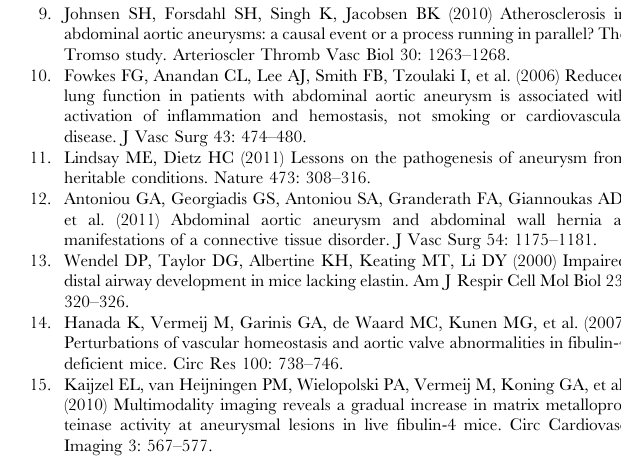
Table S1 Clinical characteristics of patients with de- scending thoracic aortic aneurysm (TAA) or abdominal aortic aneurysm (AAA). Table S2 COPD in patients with descending thoracic aortic aneurysm (TAA) or abdominal aortic aneurysm (AAA). Table S3 Association between COPD and aneurysmal disease. Table S4 The most significantly down-regulated genes in lungs of adult Fibulin-4 R/R mice. Table S5 Over-expressed canonical pathways, based on